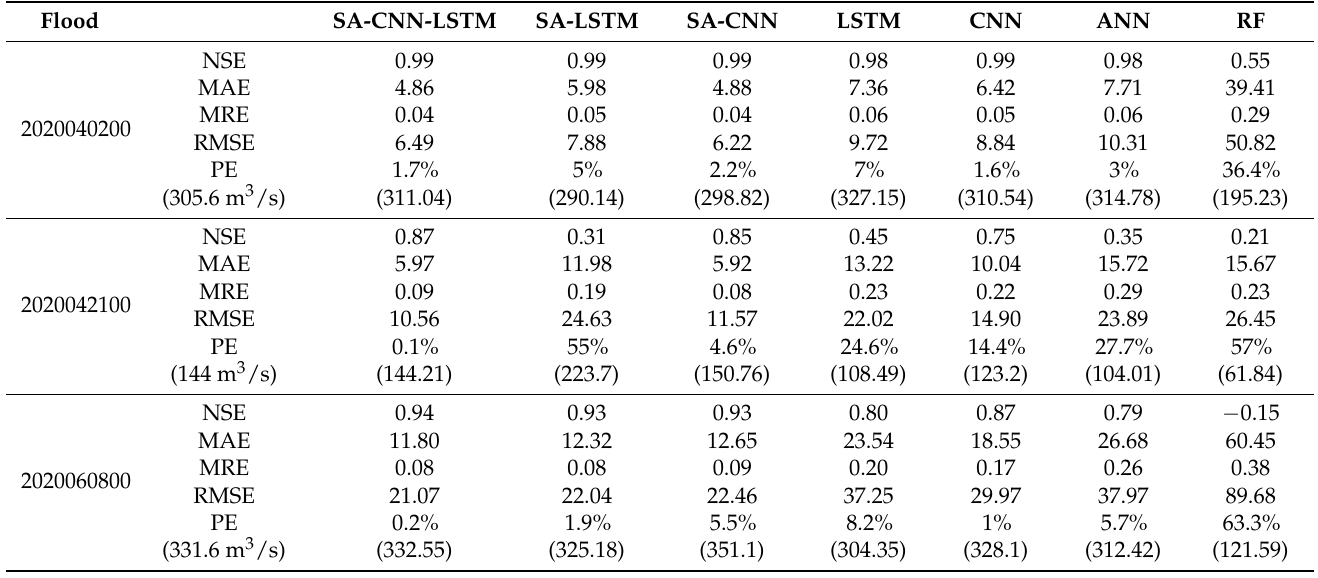
Figure 10. Comparisons of the predictions of the flood event (2021053000) from each model at the lead times of 1 ( a ), 3 ( b ), 5 ( c ), and 7 ( d ) h.